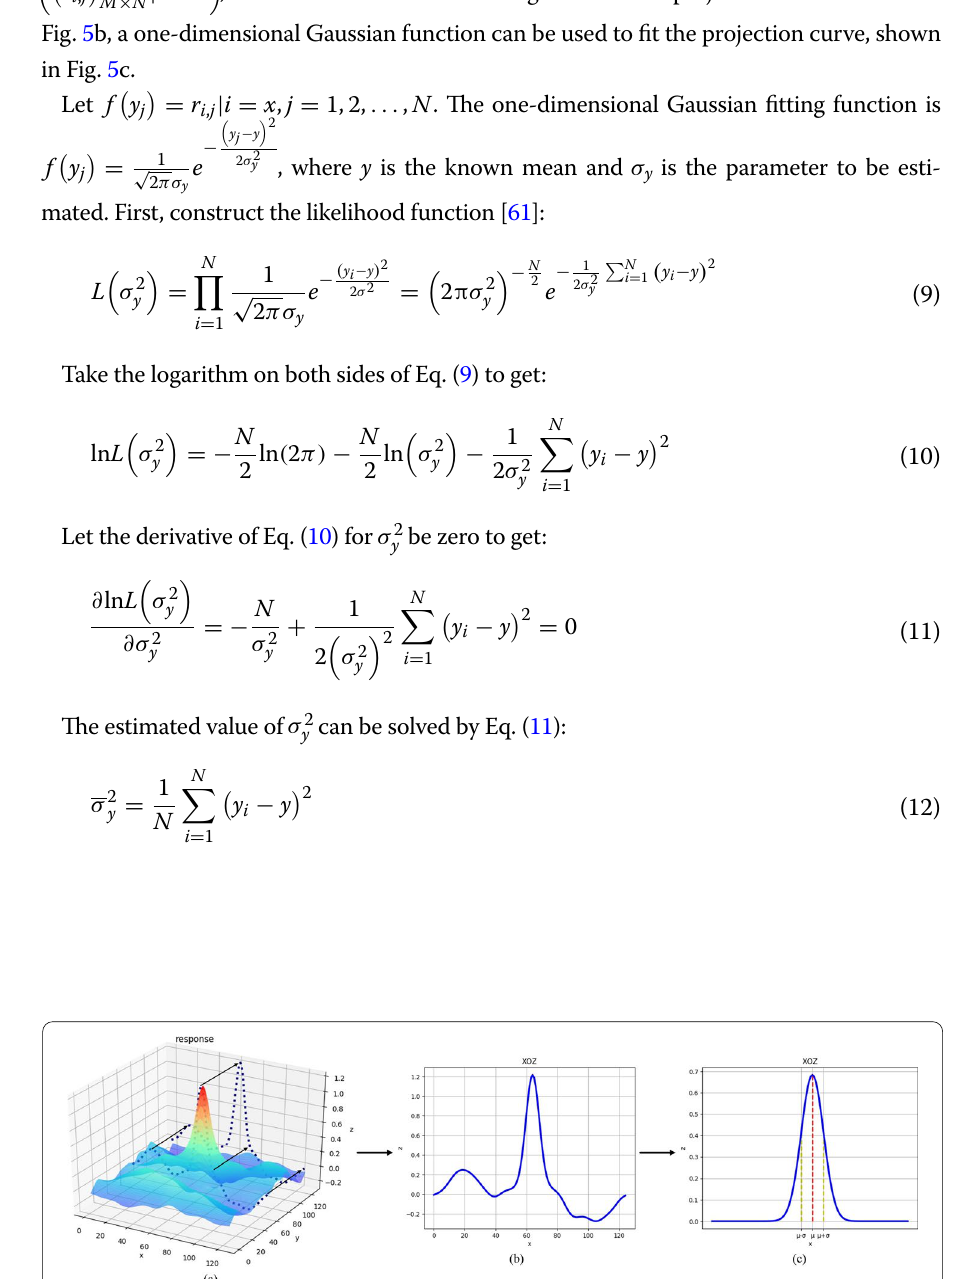
Fig. 6 Schematic diagram of the projection and fitting of the total response on the XOZ